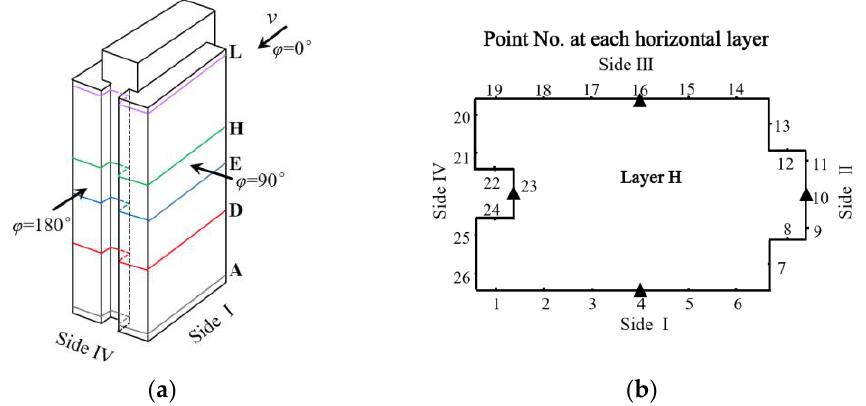
Figure 5. ( a ) Horizontal layers in three-dimensional diagram; ( b ) point No. at each horizontal layer (taking layer H as an example).